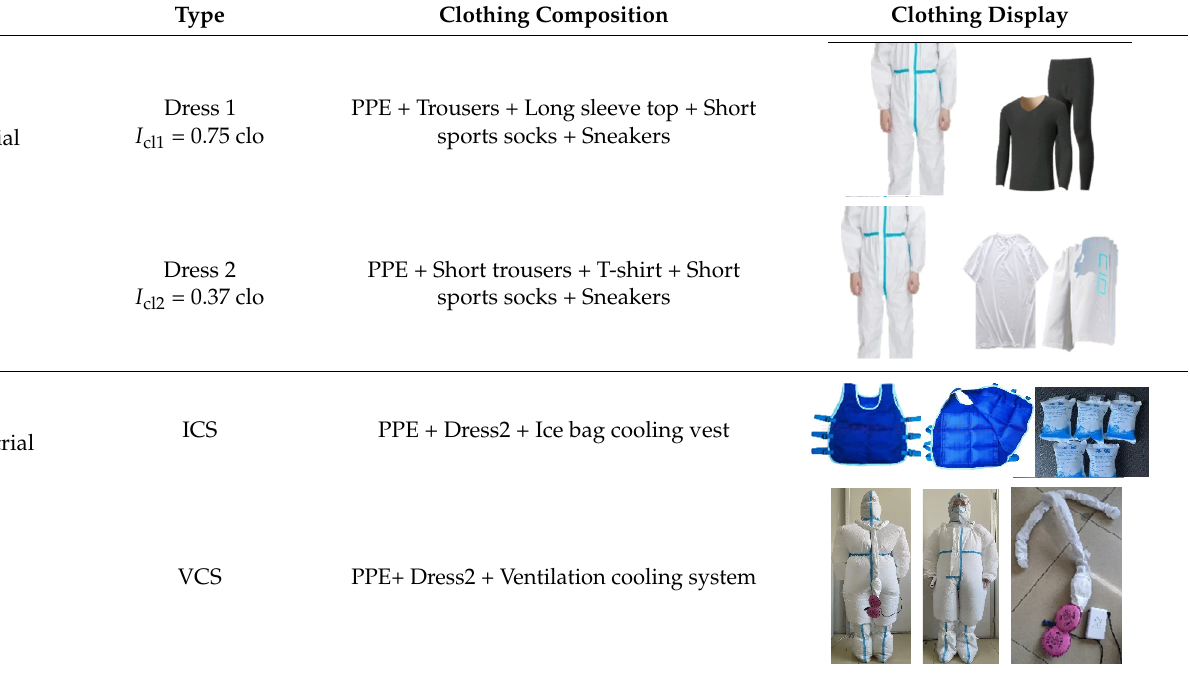
Table 4. Experimental PPE and ensembles.